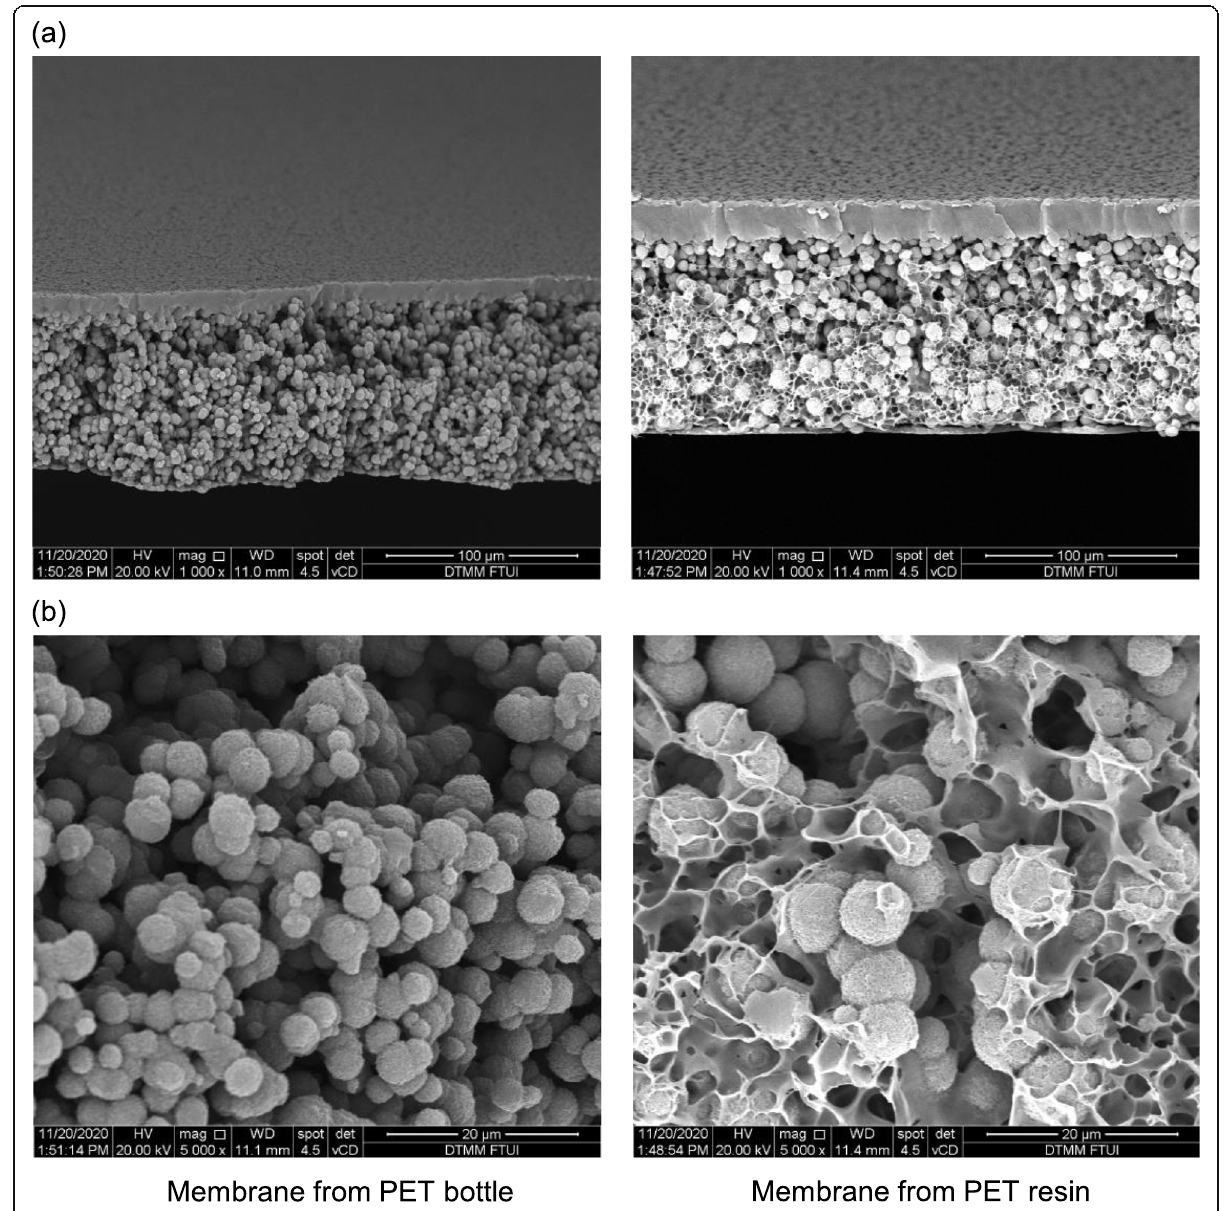
Fig. 3 SEM photographs of the cross section of the PET membrane from PET bottle and that from PET resin: ( a ) magnification: 1000 x, ( b ) magnification: 5000 x